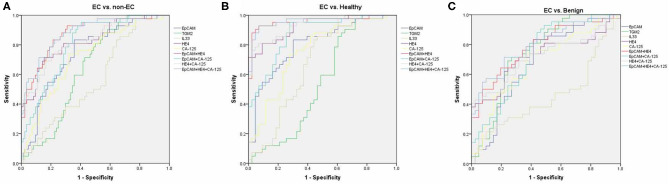
Receiver operating characteristic (ROC) curves. ROC curves for regression models using serum EpCAM, TGM2, IL-33, CA-125, HE4, EpCAM+HE4, CA-125+HE4, EpCAM+CA-125, and EpCAM+CA-125+HE4 to distinguish EC from non-EC (A), healthy (B), and benign group (C), respectively.